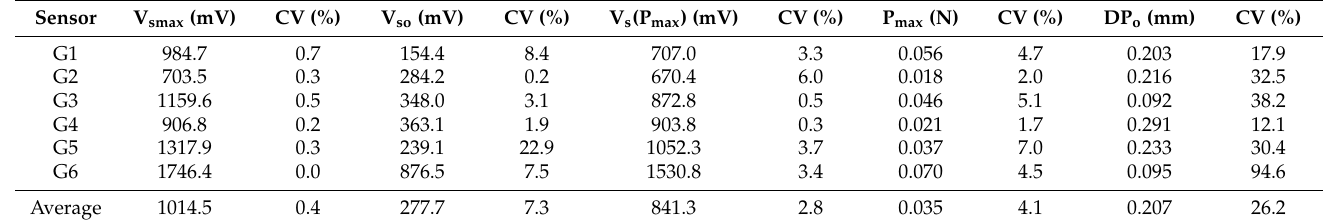
Table 2. Experimental values of generic parameters for load and instrumental signal.